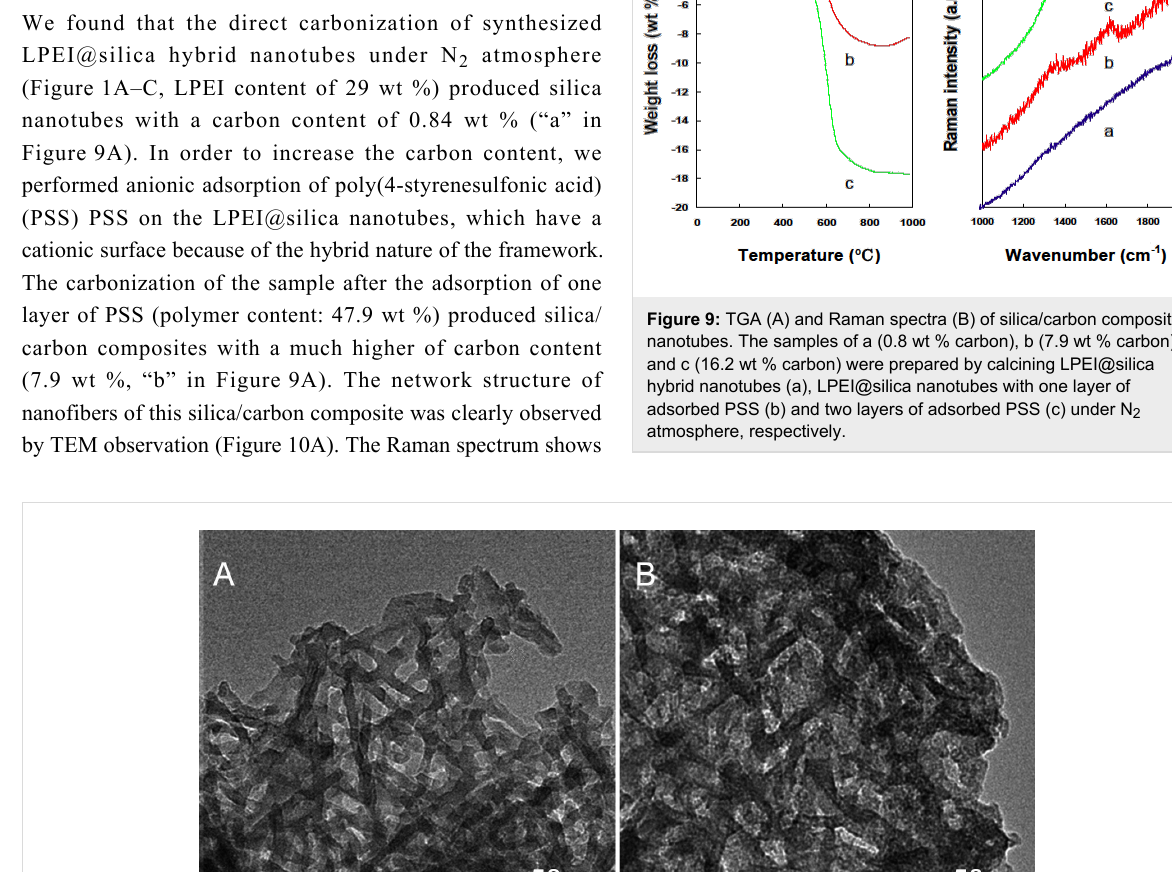
Figure 10: TEM images of silica/carbon composite mats with a nanofibrous network prepared by calcining LPEI@silica nanotubes under N 2 atmos- phere after PSS adsorption of one layer (A) and two layers (B).